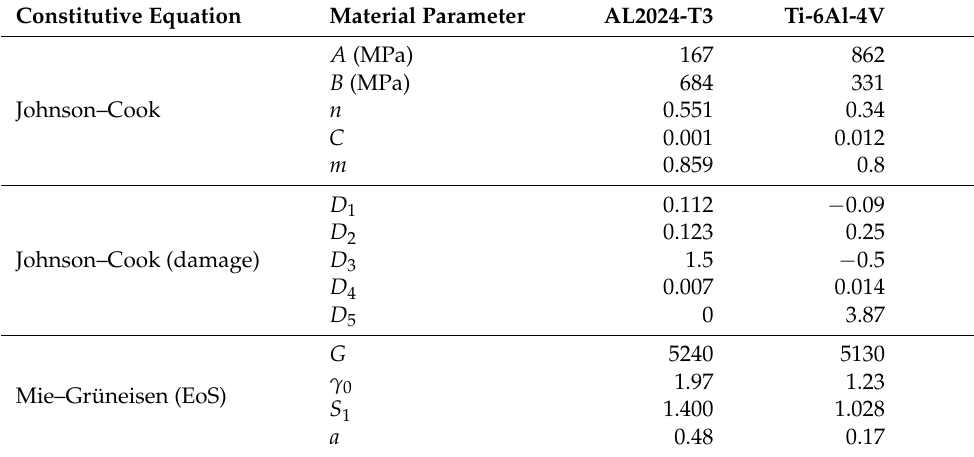
Table 1. Johnson–Cook constitutive and damage models, and Mie–Grüneisen equation of state parameters for AL2024-T3 (debris particle, shield and honeycomb core) and Ti-6Al-4V (honeycomb core) [21,22].